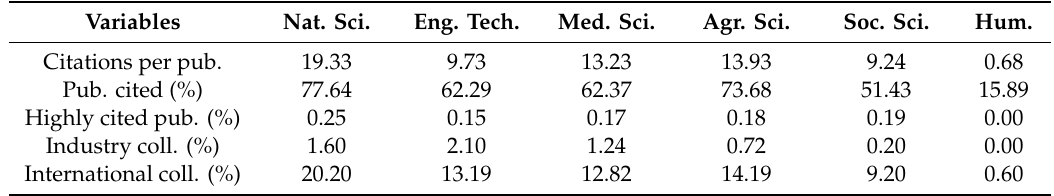
Table 1. Median values of variables for six main areas by category (1980–2020) 1 .